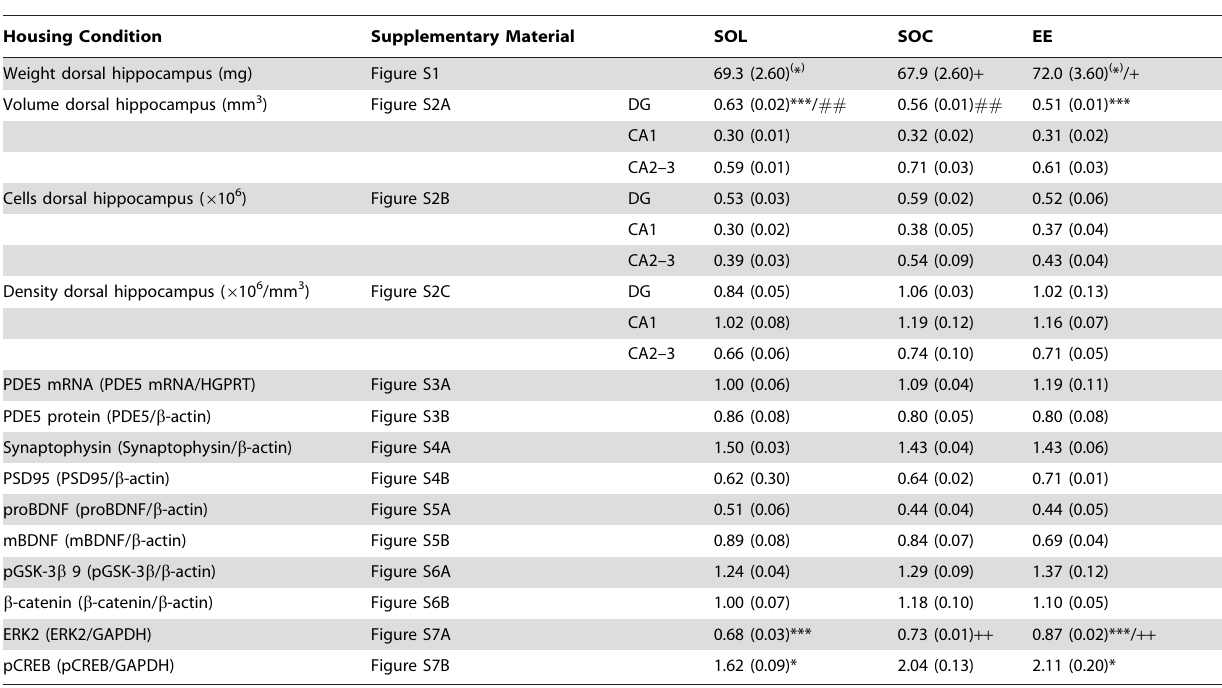
Table 2. Results stereological and biochemical measurements.